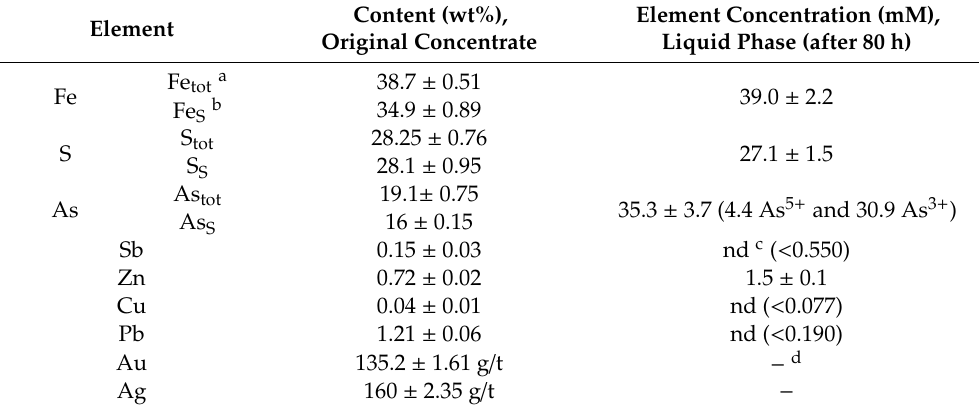
Table 1. Contents of the main elements in the original sulfide concentrate and concentrations of metal(loid)s in the liquid phase after 80 h of cultivation with Sb. thermotolerans